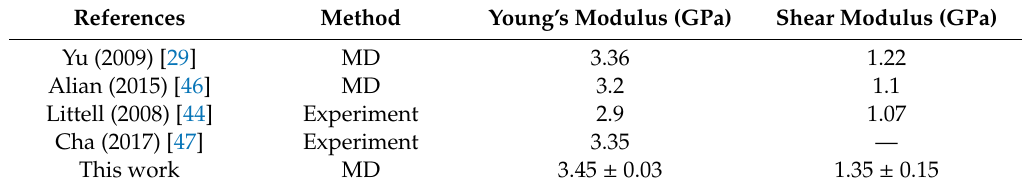
Figure 3. ( a ) The stress-strain curve of pure cross-linked epoxy under uniaxial tension, ( b ) the variation of total energy during tension. Table 2. The calculated mechanical properties of pure cross-linked epoxy and relevant values obtained by previous simulations or experiment.